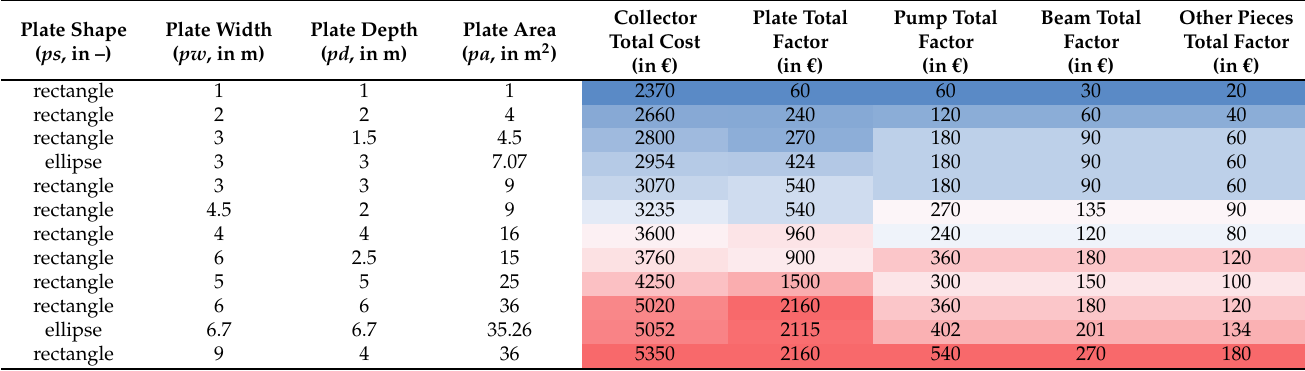
Table 8. Collector cost—Equation (6)—and their total factors for the combination of the relevant parameters. The darkest red cell is the highest value per column, and the darkest blue reflects the lowest one. Plate Shape ( ps , in –) rectangle